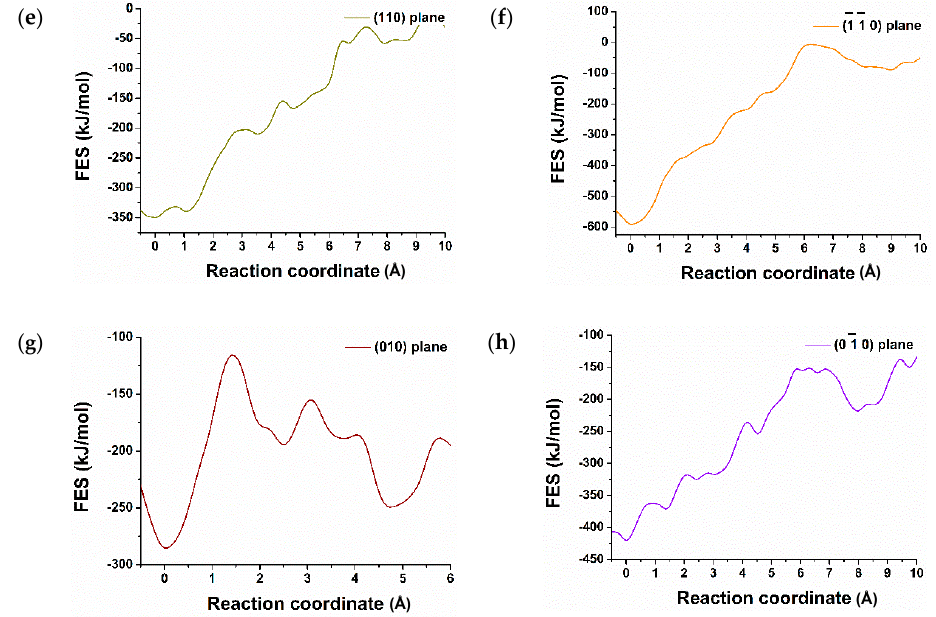
Figure 3. Dissolution profile (free energy surface) of calcium from (011), ( 01(cid:3364)1(cid:3364) ), (001), (101), (110), ( 1(cid:3364)1(cid:3364)0 ), (010), ( 01(cid:3364)0 ) surfaces of C 3 S ( a – h ) and reactivity difference among them at 298 K. Contrariwise, the dissolution profile of calcium from (001) surface shows the opposite trend and supports the results that were predicted after 600 picoseconds of hydration (Figure 1b). The complete dissolution of Ca-1957 from (001) surface was required to overcome the barrier of 12.50 kJ/mol at 0.43 × 10 − 10 m and 50.00 kJ/mol at 20 × 10 − 10 m. The total free energy change ( Δ G) of +14.00 kJ/mol at 298 K represents an endergonic reaction and is thermodynamically unfavorable [26,27]. This explains the reduced reactivity and water tessellation of the (001). Likewise, Ca dissolution from (010), ( 01(cid:3364)0 ), (110), ( 1(cid:3364)1(cid:3364)0 ) surfaces required a very high activation barrier (Table 1), therefore, these surfaces are less reactive toward hydration, endergonic and thermodynamically not favorable. Table 1. Free energy change of different surfaces of C 3 S during the dissolution of calcium.